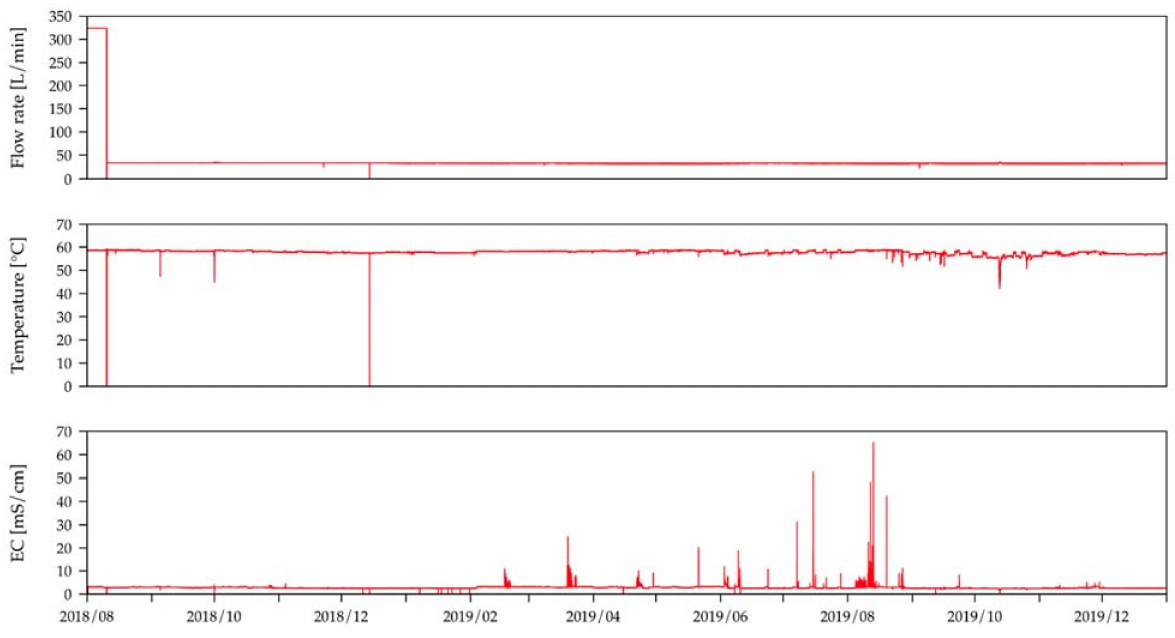
Figure 3. Values measured by the monitoring